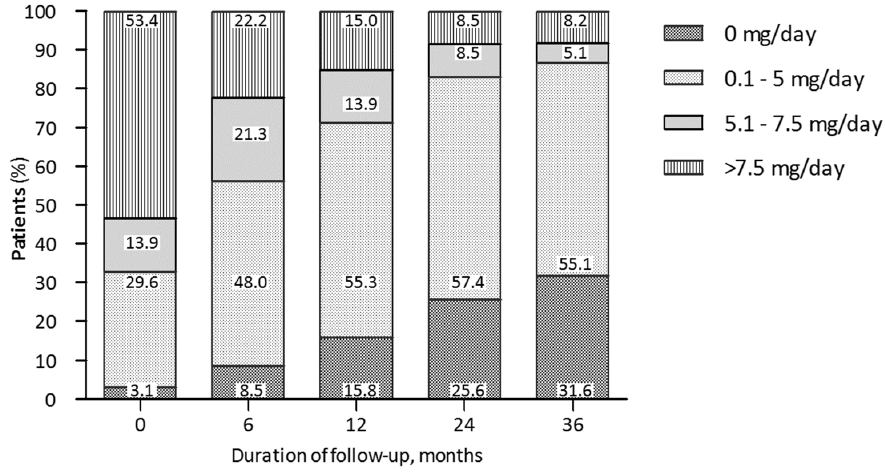
Figure 4. Trends in daily dose PDN intake during belimumab treatment in patients with joint and skin manifestations at di ff erent timepoints. skin manifestations at different